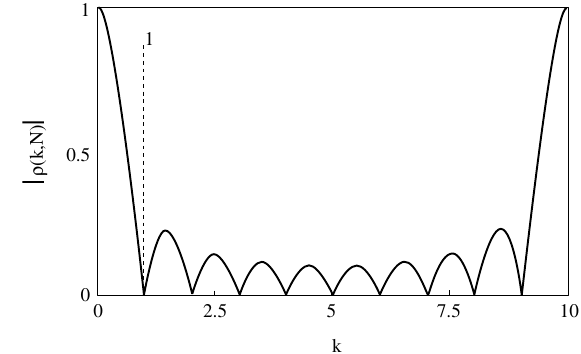
FIG. 9. Fourier transform of a beamlet composed of ten macroparticles. The spectral content of the distribution is zero at k (cid:6) 1 : 9